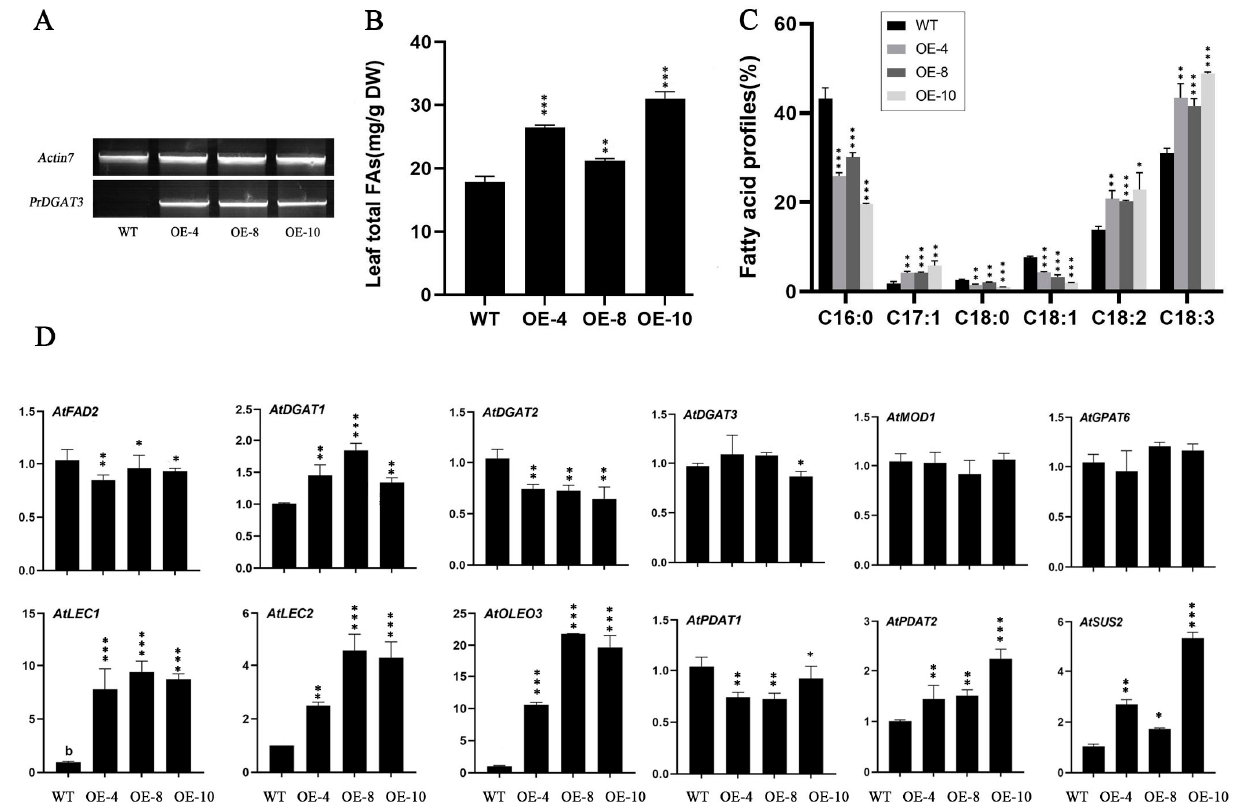
Figure 6. Functional verification of PrDGAT3 in transformed Arabidopsis . ( A ) RT-PCR analysis of PrDGAT3 expressed in transgenic Arabidopsis rosette leaves. ( B ) Total oil content in Arabidopsis rosette leaves between the wild-type (Col-0) and the PrDGAT3 transgenic plants (% dry weight). ( C ) Major fatty acid profiles in TAG between the wild-type (Col-0) and PrDGAT3 transgenic plants. ( D ) Comparison of the expression levels of fatty acid and TAG biosynthetic genes between the wild-type (Col-0) and PrDGAT3 transgenic plants. Values are mean ± SD ( n = 3). * p < 0.05, ** p < 0.01, *** p < 0.001.